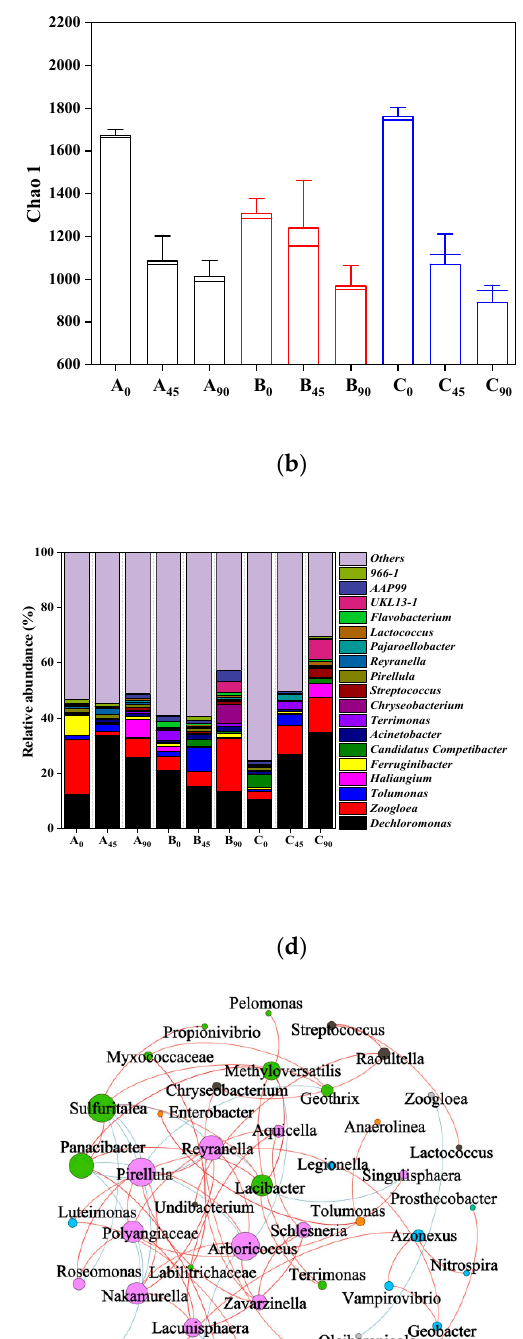
11 of 19 microbial community relationships to carry out in-situ sludge reduction in the bioreactors [10], which will be discussed in the following section. The microbial composition was classified at the phylum level, as presented in Figure 5c. Proteobacteria , Bacteroidetes , Firmicutes and Planctomycetes were the major phyla throughout the sludge reduction process. In all the bioreactors, the relative abundance of Proteobacteria increased with the operation time, and AOA 80 had the highest abundance at the 90th day of operation. Proteobacteria was known as the dominant hydrolytic and acidogenic bacteria with the potential for polysaccharide degradation [47]. Bacteroidetes played a strong role in large molecular organic matter degradation, i.e . , proteins and polysaccharides [48]. The relative abundance of Bacteroidetes in AOA 90 increased with the